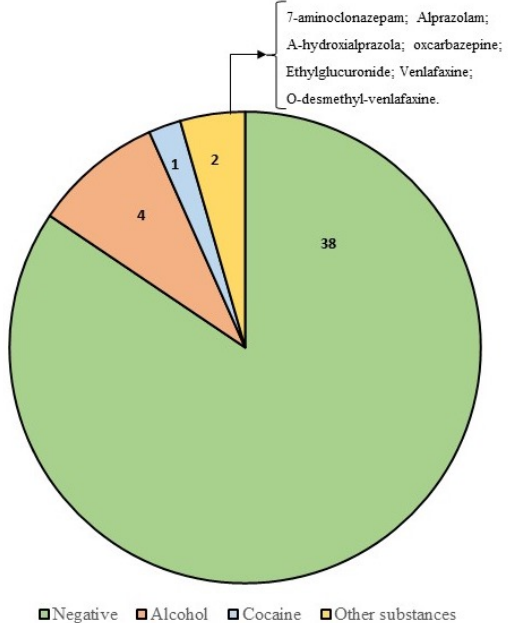
Figure 11. The graph summarizes the results of the toxicological screening. The alcohol concentration in all cases was studied in blood, with 4/45 cases testing positive. Psychoactive substances, such as venlafaxine and benzodiazepines, were found in two cases. Table 5 summarizes the results of the toxicological